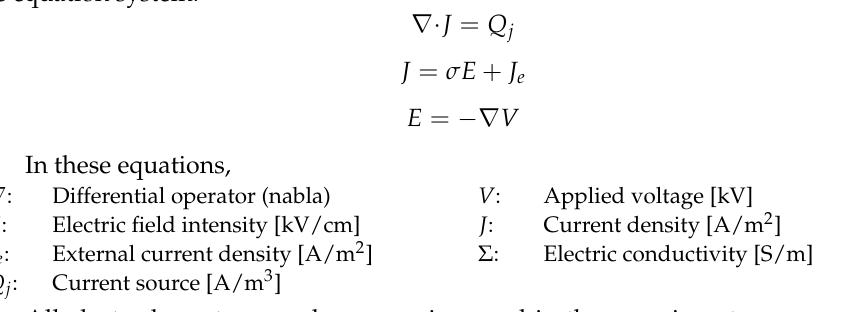
Figure 19. The mesh form of rod (R = 6 mm)–plane electrode system.